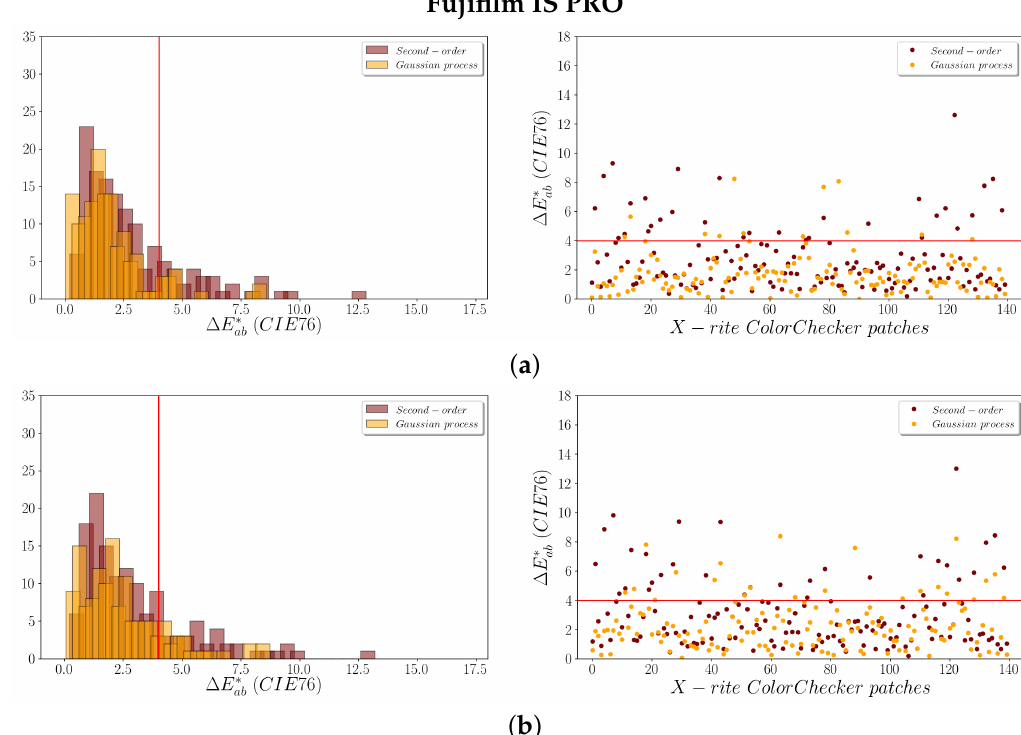
Figure 5. Fujifilm IS PRO ∆ E ∗